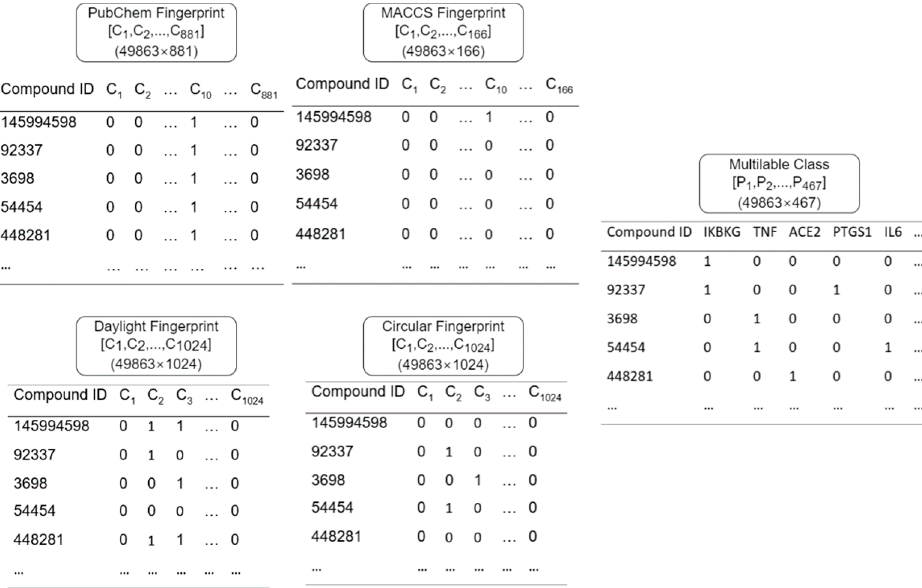
Figure 3. Example of all feature extraction data and multilabel class data.